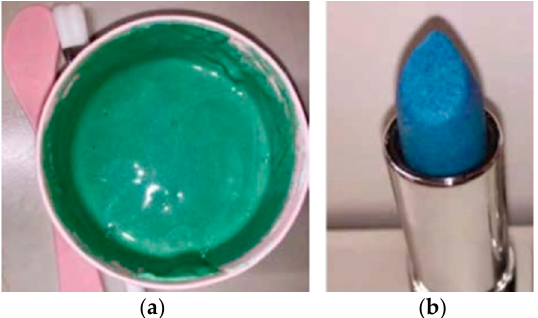
Figure 4. Two formulas made by AromataGroup: ( a ) Mermaid Instant Mask with spirulina and rameic chlorophyll and ( b ) Marble Lipbalm with spirulina extract. Published by ref. [47].